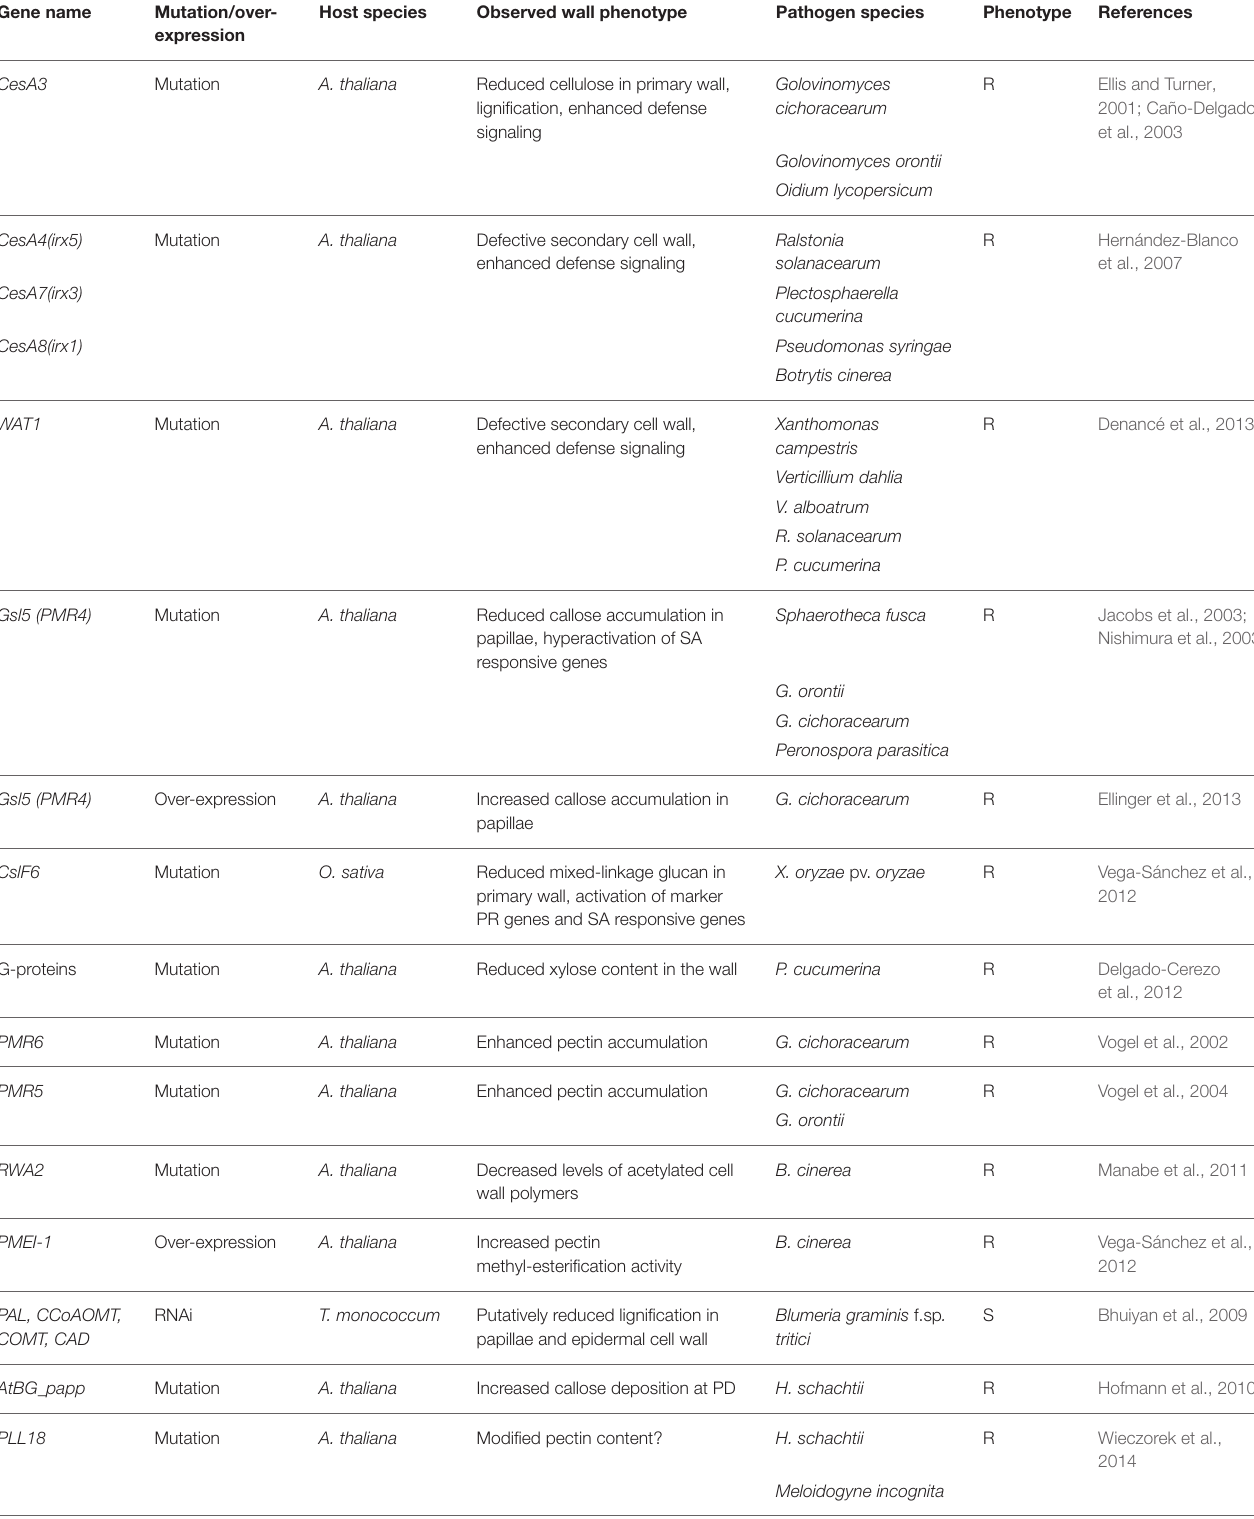
TABLE 1 | Plant:biotic stress resistance phenotypes with altered cell wall